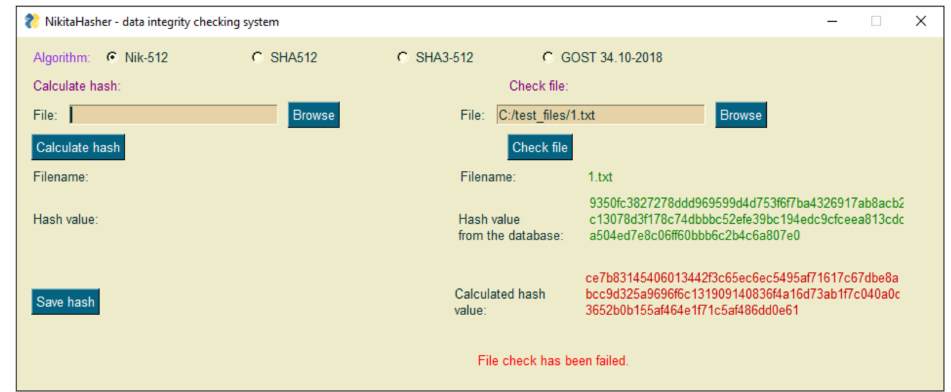
Figure 7. A failed data integrity check.